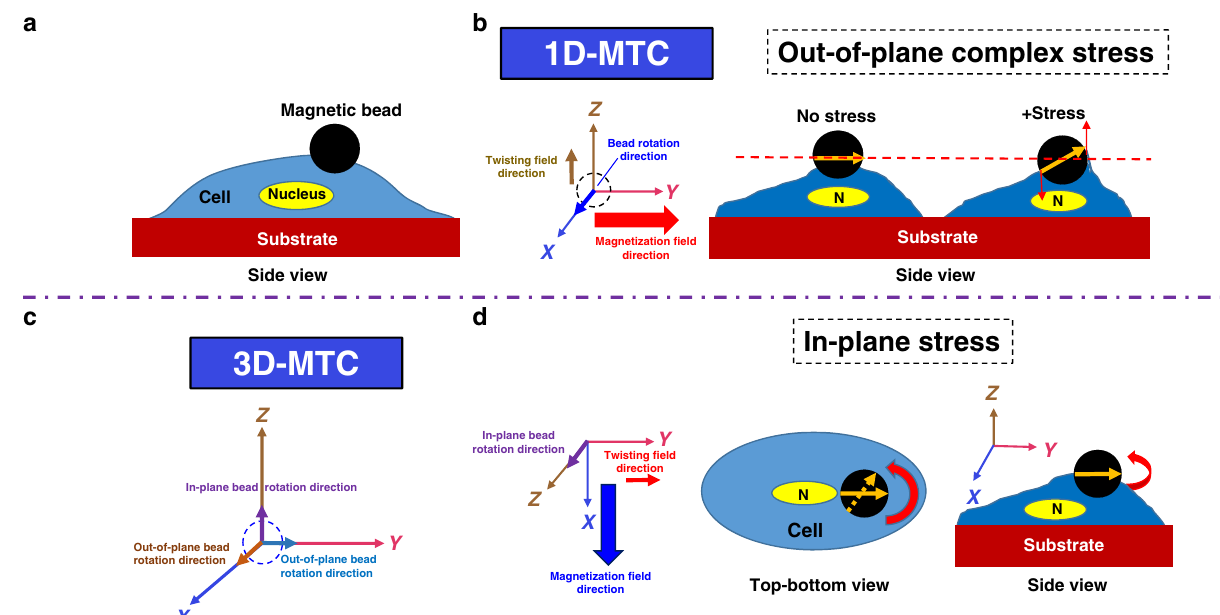
Fig. 1 Strategies of applying different stress modes to a cell. a Schematic of the cell (blue color) with its nucleus (yellow color); the big black dot was the ferromagnetic bead. The cell was placed in a culture dish in the center of the coils and the focal plane of the microscope. Not drawn to scale. b Schematic of one dimensional magnetic twisting device (1D MTC) to apply force on the cell. The bead rotated in the Y – Z plane about the X -axis (torque was in the x direction) and generated a local complex stress. c Schematic of three-dimensional magnetic twisting device (3D MTC) to apply force on the cell. The bead rotated in the X – Z plane (out-of-plane) about the Y -axis (the right-hand rule), the Y – Z plane (out-of-plane) about the X -axis, or the X – Y plane (in-plane) about the Z -axis. d Schematic of magnetizing the magnetic bead in the X direction and twisting it in the Y direction. The bead rotated in the X – Y plane (about the Z -axis) which was parallel to the substrate surface of cell spreading and generated a local